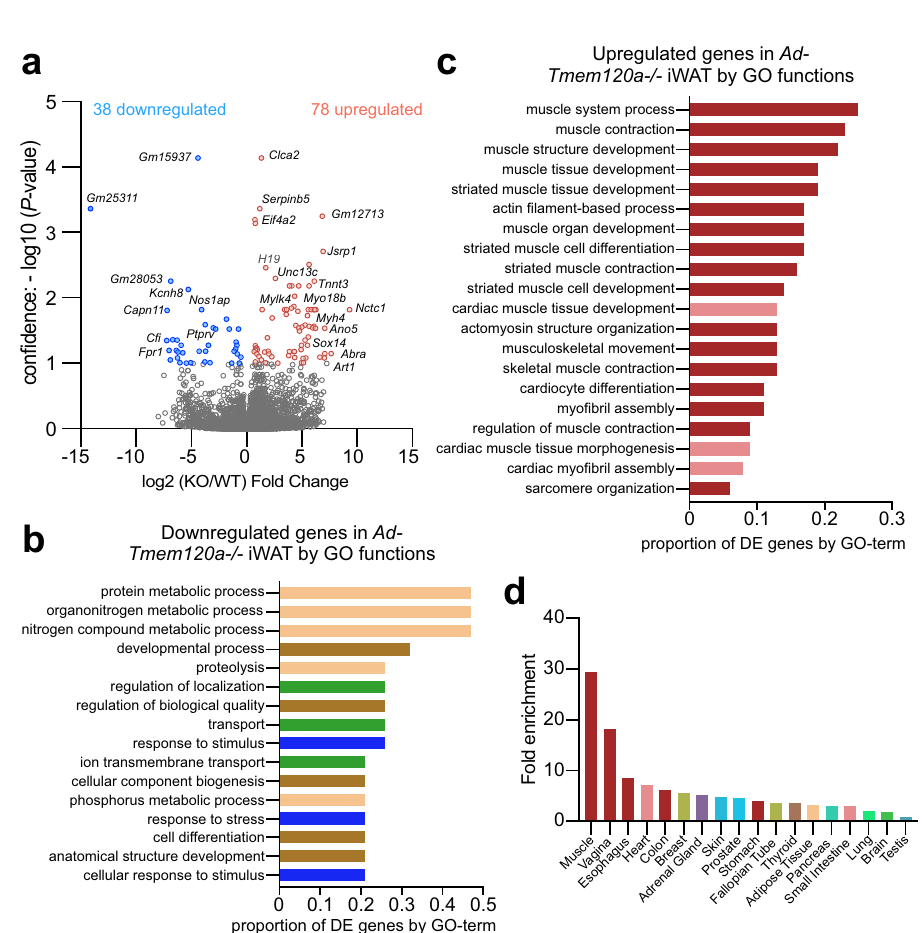
Fig. 4 Ad-Tmem120a -/- mouse exhibits de-repression in inguinal WAT of many genes that normally repress myogenesis. a Volcano plot of genes altered in inguinal subcutaneous white adipose tissue from control and Ad-Tmem120a − / − female mice on HFD ( n = 5). b Gene Ontology (GO) Biological Process analysis for downregulated genes. GO terms found to be signi fi cantly enriched using g:Pro fi ler fall into four classes: metabolism (beige), development (brown), transport (green) and response to stimulus (blue). The bars represent the proportion of genes associated with each individual enriched GO term that are present in the downregulated genes dataset. c Gene ontology (GO) Biological Process of analysis for upregulated genes. All of the enriched GO terms are related to muscle function, either skeletal (dark red) or cardiac (pale red). The bars represent the proportion of genes associated with each individual enriched GO term that are present in the upregulated genes dataset. d Tissue-speci fi c gene enrichment for upregulated genes in iWAT from Ad-Tmem120a − / − mouse by TissueEnrich tool presented as fold enrichment. Source data are provided as a Source Data fi regulation, failing to be released when Tmem120a was positional regulation and 28% (161) were under combined knocked down. The numbers increased to 43% (480 genes) Tmem120a/Tmem120b positional regulation. when considering those that failed to be released in the To directly match repositioning and expression changes, we Tmem120a / Tmem120b double knockdown. For those in newly used microarrays on RNA isolated from parallel samples to the formed adipocyte LADs, 24% (136) were under Tmem120a DamID. GO analysis for these revealed similar functions as the